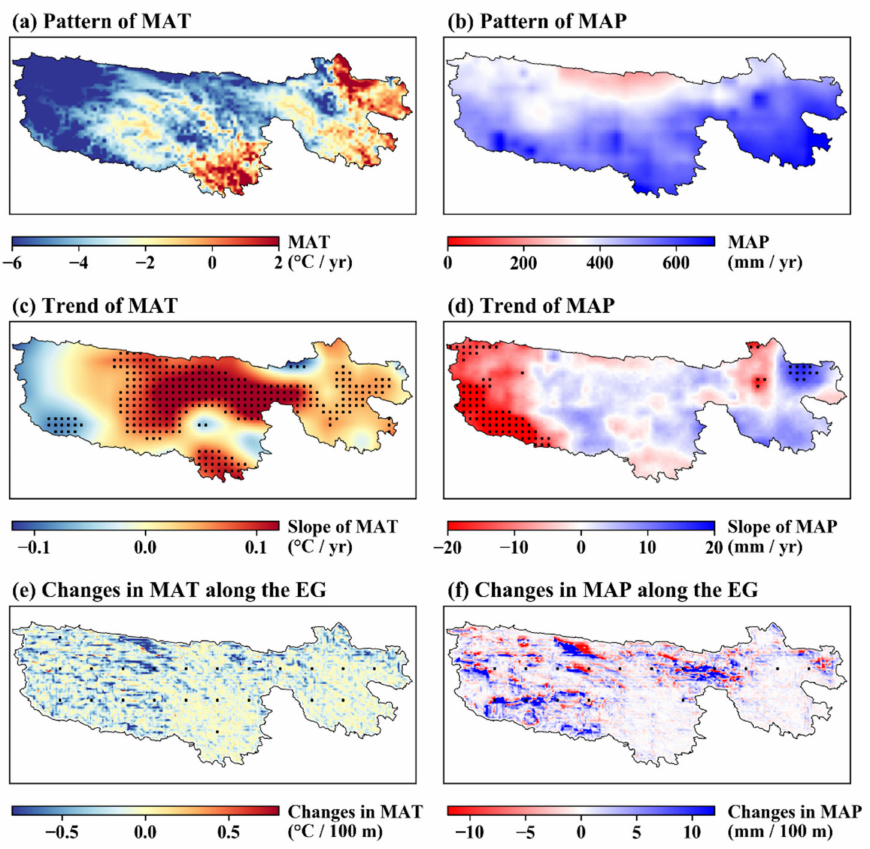
Figure 5. Pattern: ( a , b ), trend: ( c , d ) of MAT (mean annual temperature) and MAP (mean annual precipitation), and their changes along the EG (elevation gradient) ( e , f ) in the TRSR from 2001 to 2016. The regions with black dots indicate that the trend is statistically significant at the 0.05